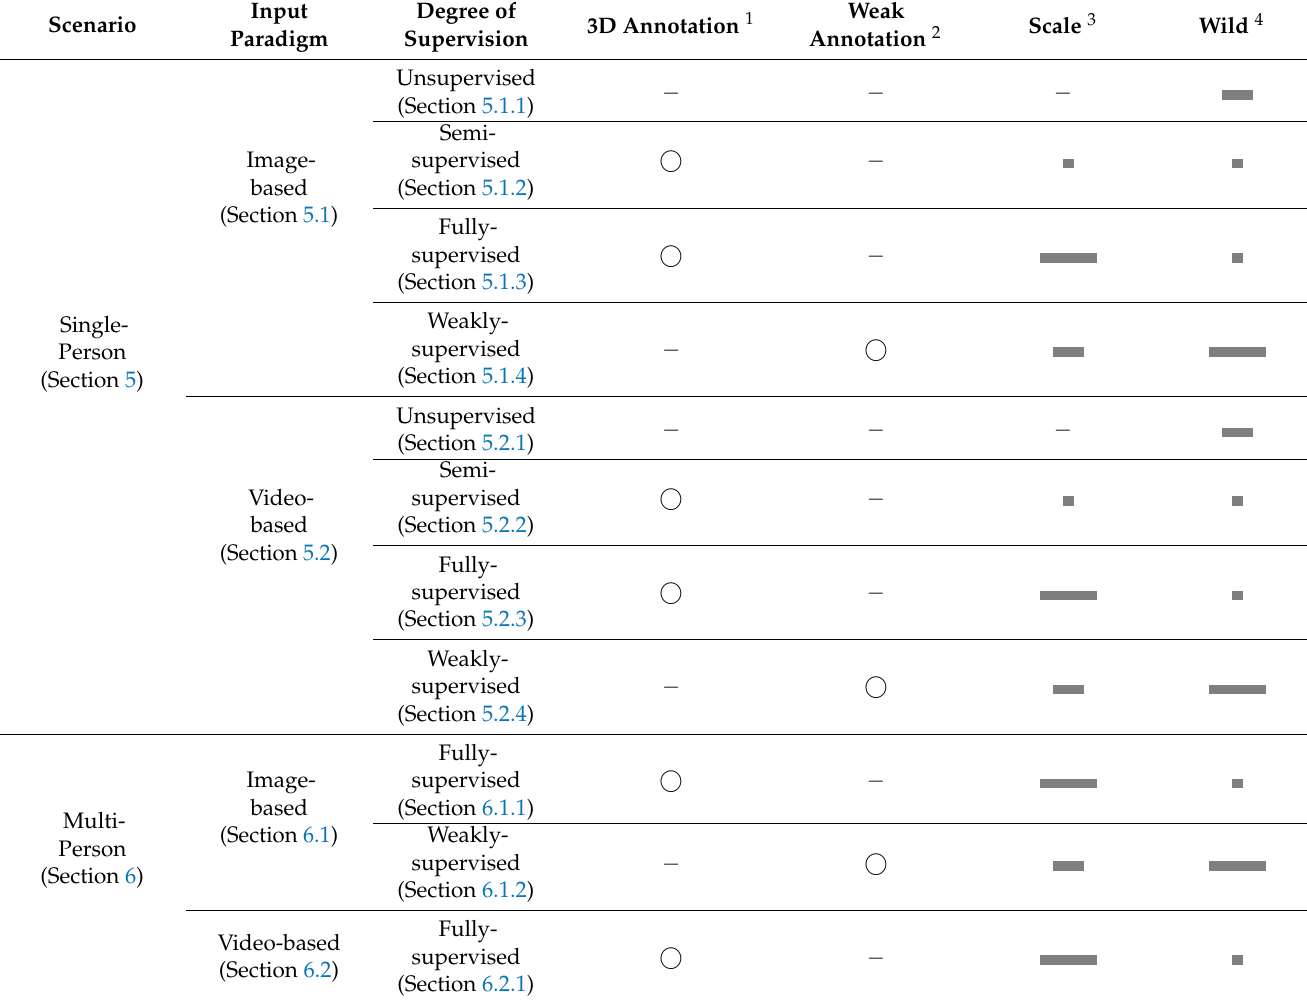
Table 1. A taxonomy of deep learning methods for 3D human pose